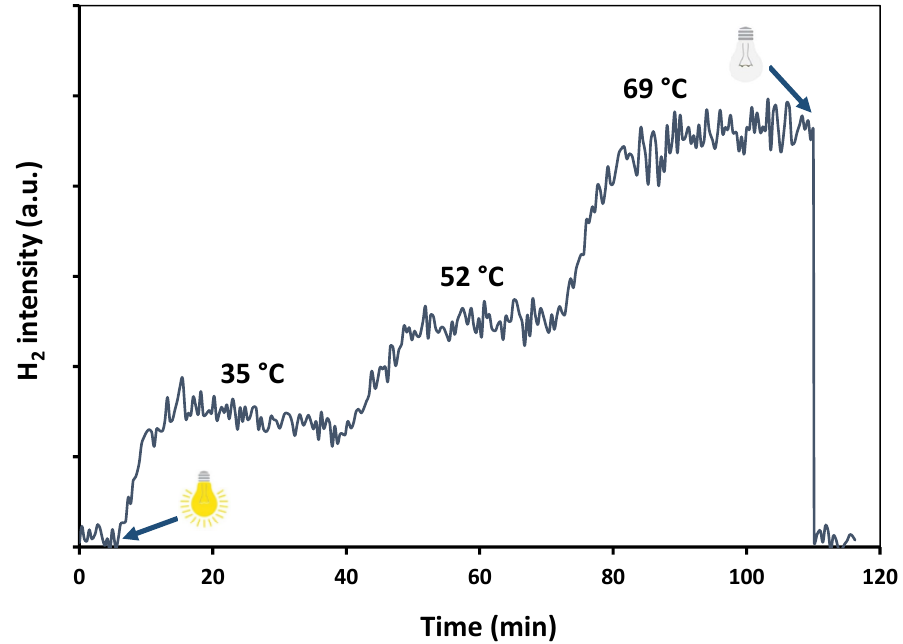
Figure 2. Typical temperature-dependent profile of H 2 emission during photolysis of 0.5 M 1-BuOH with white light of an Xe lamp under Ar flow (45 mL · min − 1 ) in the presence of Ti@TiO 2 NPs. H 2 was measured online in the outlet gas using mass spectrometry.